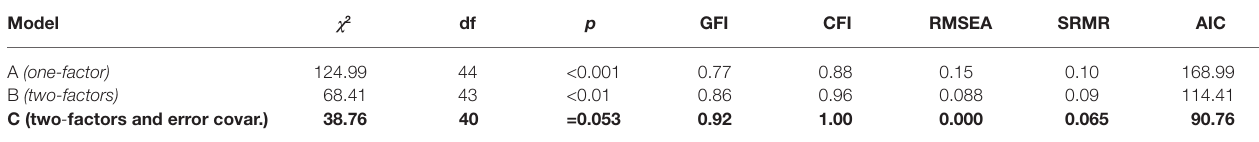
Endorsed model in bold; see Figure 3 .